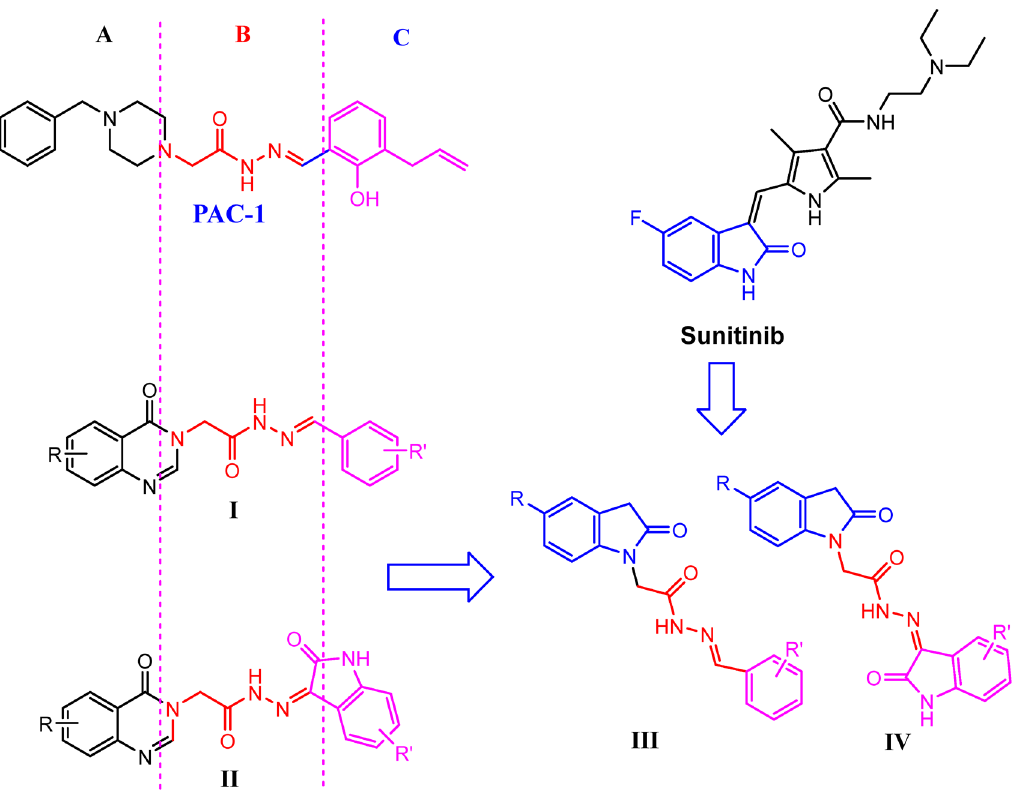
Figure 1. Structure of PAC-1, 4-oxoquinazoline-acetohydrazides ( I , II ) and design of novel 2-oxoindoline- based acetohydrazides ( III, IV